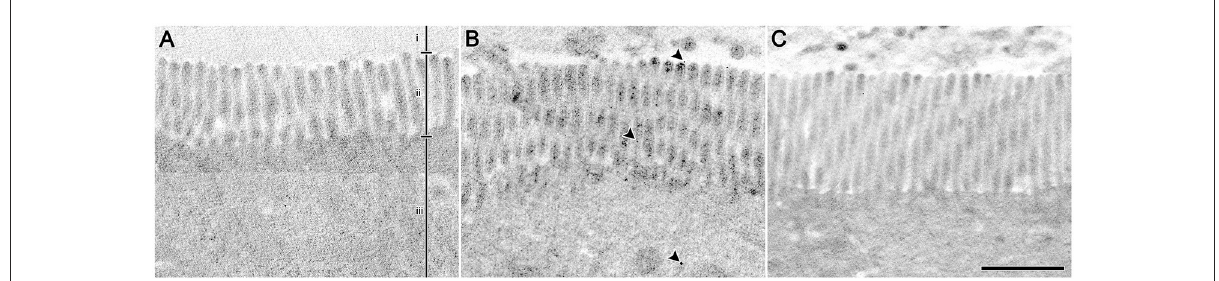
FIGURE2 Enterocytes from mouse jejunum stained with ruthenium tetroxide, counterstained with osmium tetroxide, and imaged by transmission electron microscopy. Example images showing the interface between the intestinal lumen (i), the microvilli (ii), and the intracellular regions of